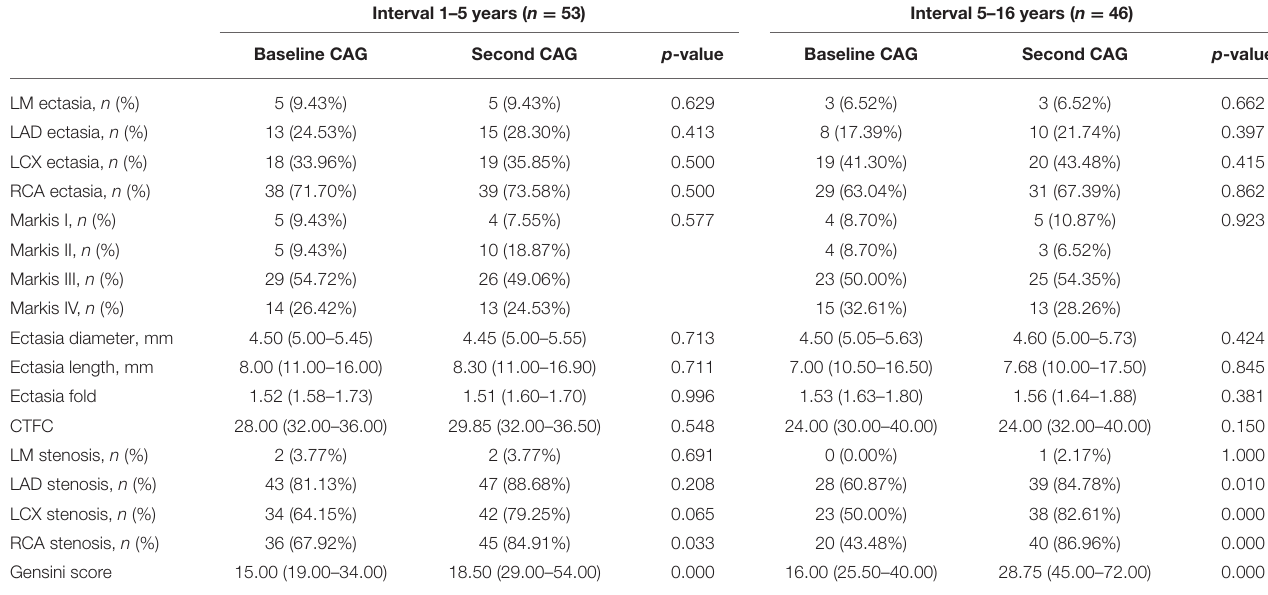
TABLE 3 | Coronary evaluations for ectasia and stenosis.